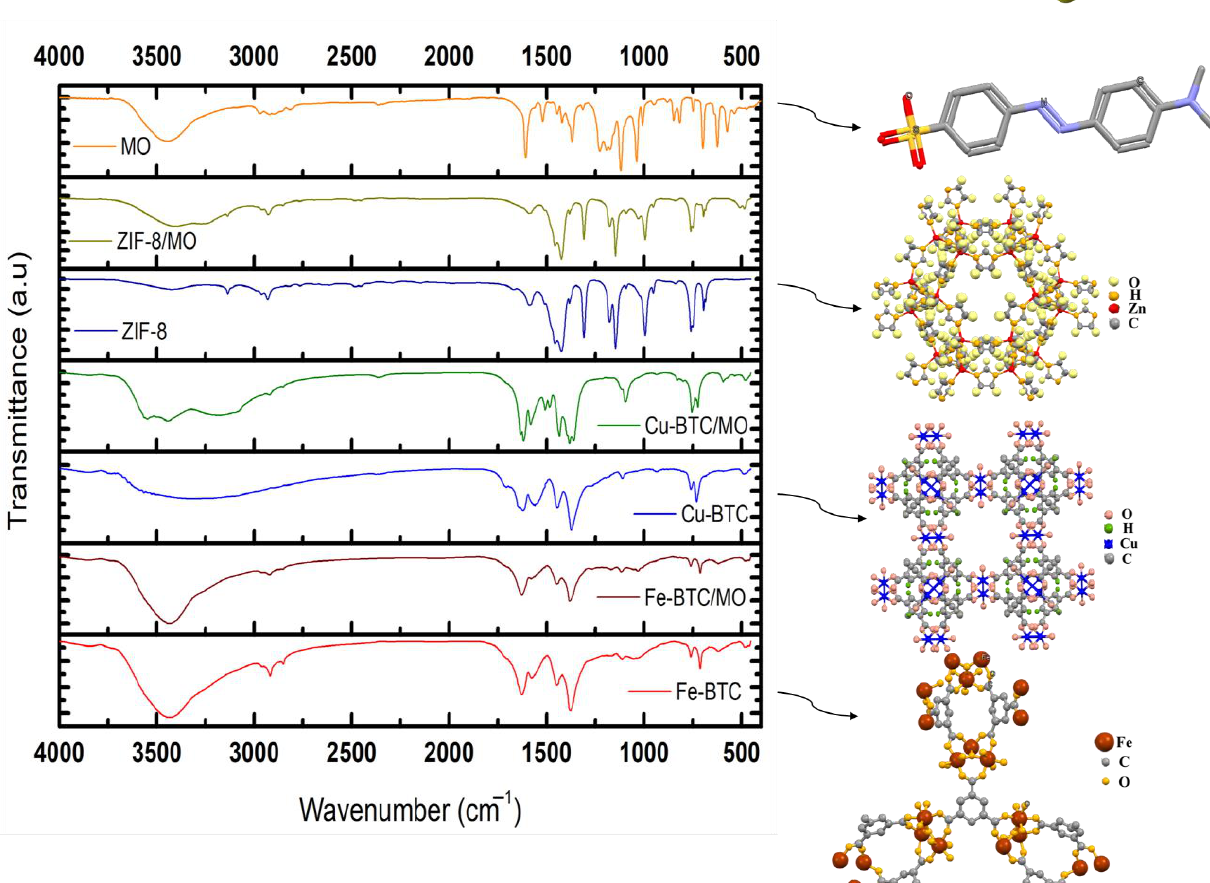
Figure 4. FTIR spectra of Fe-BTC, Cu-BTC and ZIF-8 before and after MO adsorption.